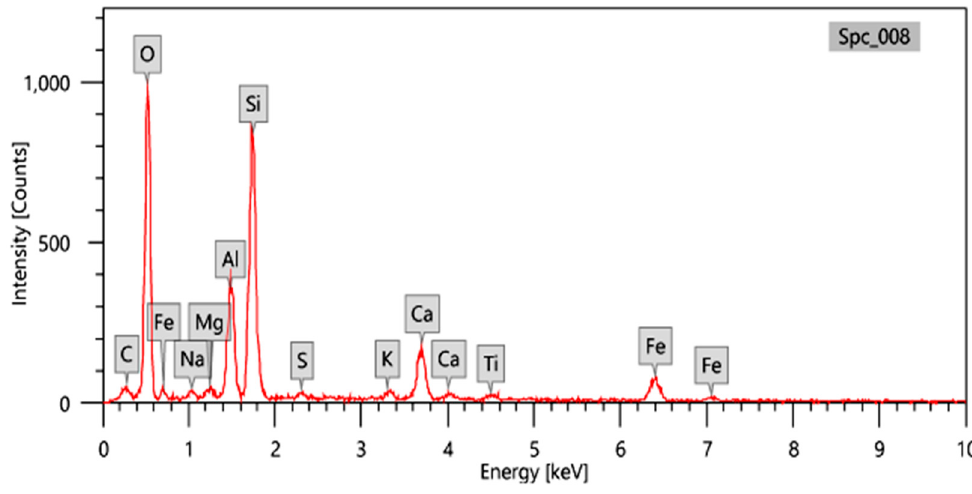
Figure 1. EDX analysis of Bentonite clay. Table 1. Chemical compositions of the bentonite clay used in this work.